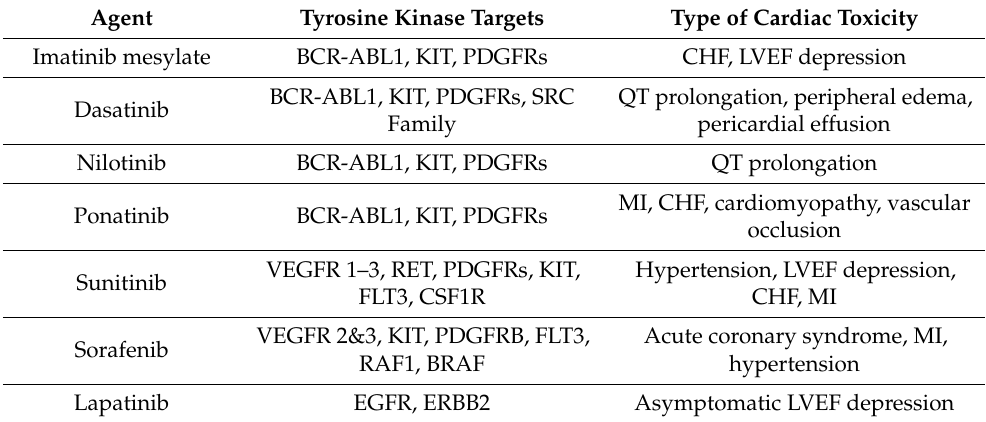
Table 1. Tyrosine kinase inhibitors and type of reported cardiotoxicity. Agent Tyrosine Kinase